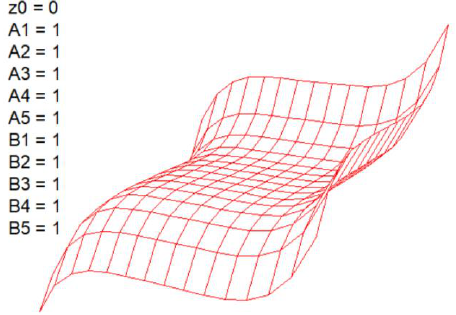
Figure 23. Formula coefficient initialization.